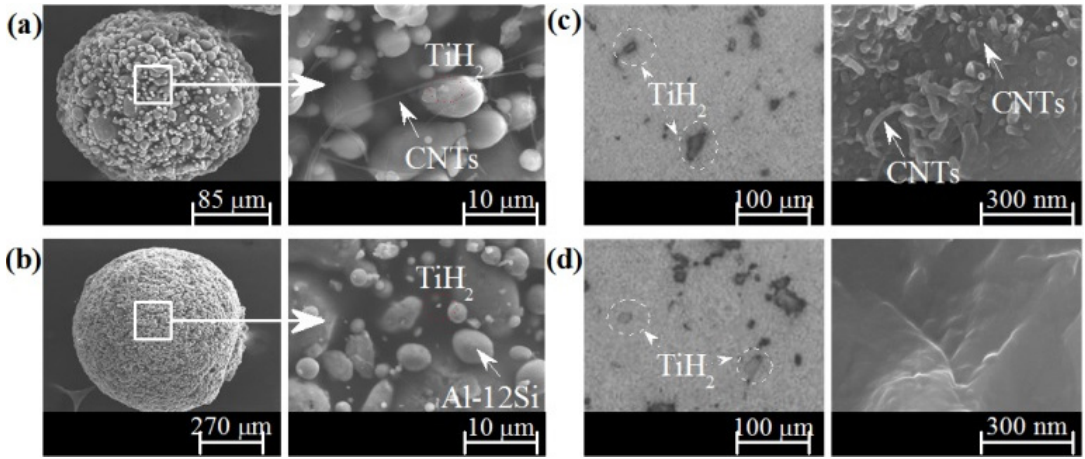
Figure 9. Highly-spherical granules prepared by freeze-granulation-lyophilisation and its surface with Figure 9. Highly ‐ spherical granules prepared by freeze ‐ granulation ‐ lyophilisation and its surface ( a ), and without ( b ), MWCNTs-COOH. Microstructural features of precursor materials (and of their with ( a ), and without ( b ), MWCNTs ‐ COOH. Microstructural features of precursor materials (and of fracture surfaces) prepared from granules with ( c ), and without ( d ), their fracture surfaces) prepared from granules with ( c ), and without ( d ), MWCNTs ‐ COOH.